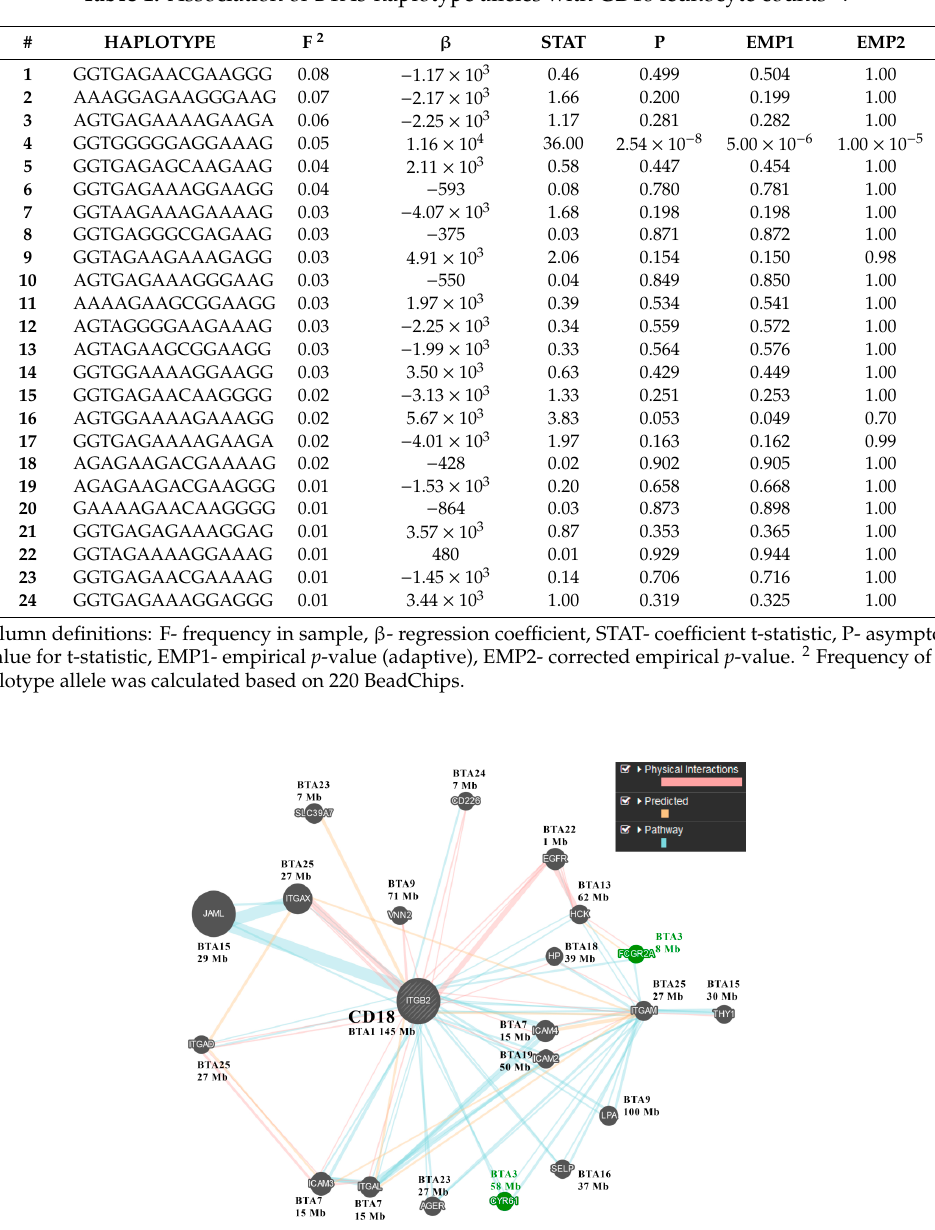
Figure 3. Sequence chromatograms of polymorphic stretch in CD32 third exon of high or low milk CD18-expressing heifers. Tail hairs of high (top) and low (bottom) CD18 leukocyte-count heifers were collected and the extracted DNA was used for simultaneous PCR amplification of the third exons encoding CD32. Forward (F) and reverse (R) orientation chromatograms show three variations (indicated by arrows) in which the ratio of nucleotide heights provides information on the number of